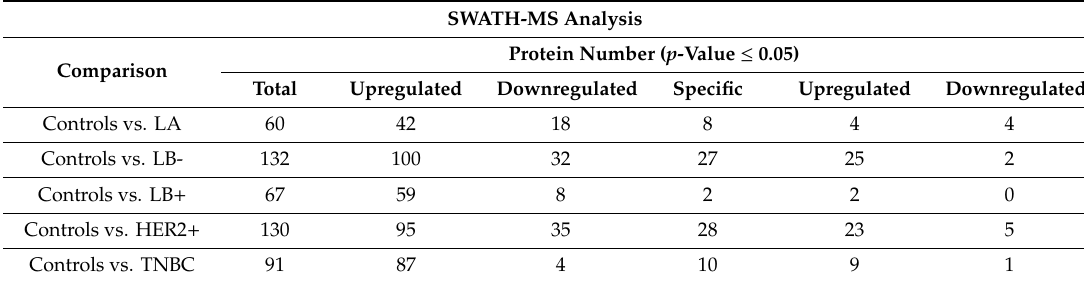
Table 1. Number of di ff erentially expressed proteins (up- and downregulated) ( p -value ≤ 0.05) found in the protein patterns of the ex vivo formed coronas after the analysis by SWATH-MS for the di ff erent breast cancer subtypes (LA LB-, LB + , HER2 + and TNBC) in comparison with healthy controls (HC) samples. The number of di ff erentially expressed proteins (up- and downregulated) specific to each of the five subtypes of BC found in the ex vivo formed coronas is also indicated.